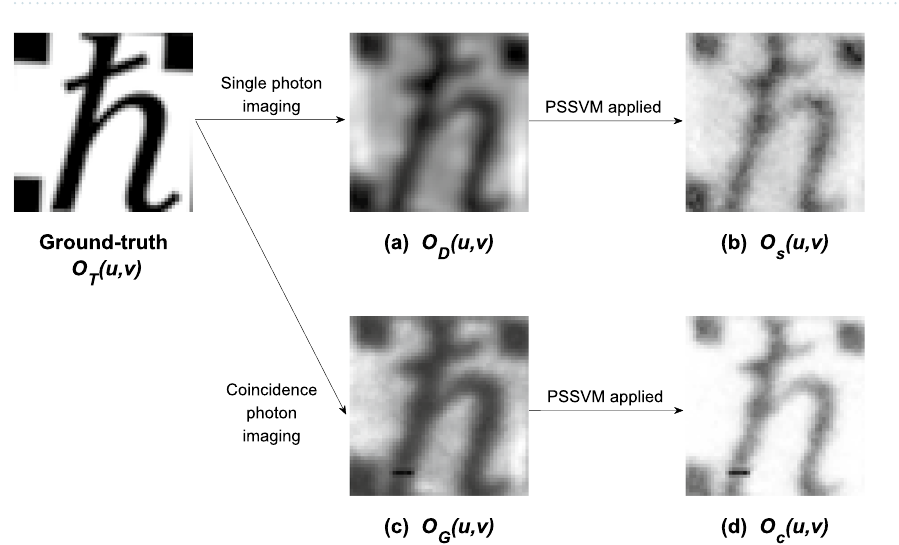
Figure 5. 50 × 50 pixel ground-truth image O T ( u , v ) . ( a ) Single-photon image O D ( u , v ) . ( b ) PSSVM applied single-photon image O s ( u , v ) . ( c ) Quantum image O G ( u , v ) . ( d ) PSSVM applied quantum image O c ( u , v ) .